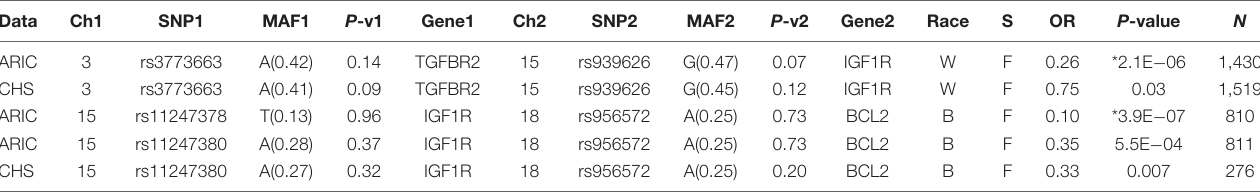
TABLE 2 | Results of associations of interactions between SNPs in selected candidate genes from aging pathways ( Table 1B ) with survival to age 85 + in ARIC and CHS